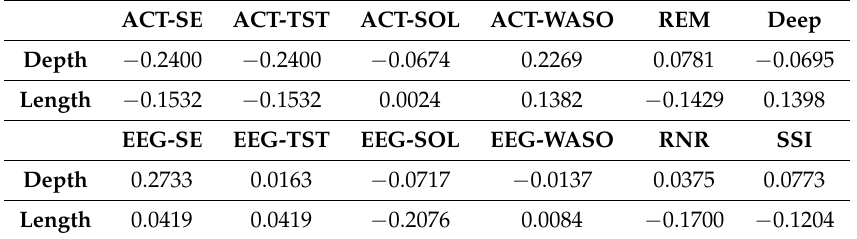
Table 4. The correlation coefficient using Spearman’s Roh between subjective sleep assessment (Depth, Length) and objective sleep evaluation (SE, TST, SOL, WASO, REM, Deep, RNR, and SSI). ACT-SE ACT-TST ACT-SOL ACT-WASO REM Deep Depth − 0.2400 − 0.2400 − 0.0674 0.2269 0.0781 − 0.0695 Length − 0.1532 − 0.1532 0.0024 0.1382 − 0.1429 0.1398 EEG-SE EEG-TST EEG-SOL EEG-WASO RNR SSI Depth 0.2733 0.0163 − 0.0717 − 0.0137 0.0375 0.0773 Length 0.0419 0.0419 − 0.2076 0.0084 − 0.1700 −